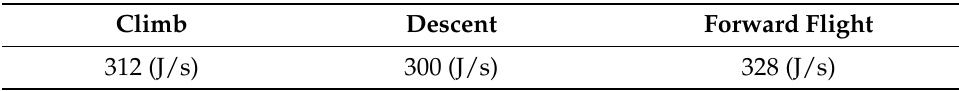
Table 2. Flight power consumption data from